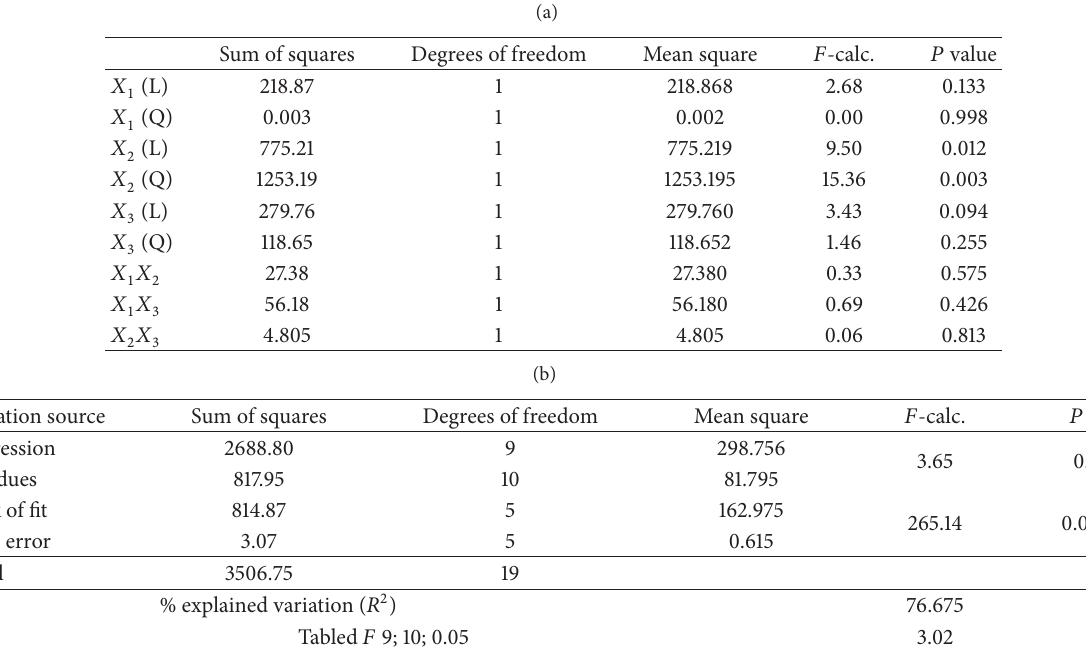
Table 3: (a) Results of the analysis of variance applied to residual doxycycline concentration data collected at the end of the Fenton process under different operating conditions. (b) Results obtained by the quadratic model.